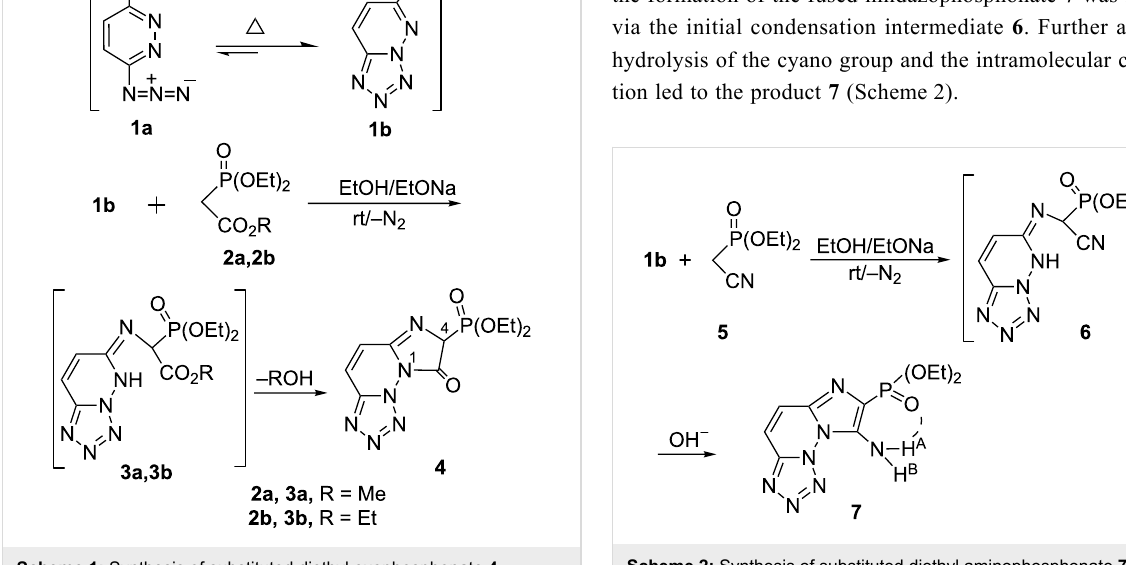
Scheme 2: Synthesis of substituted diethyl aminophosphonate 7